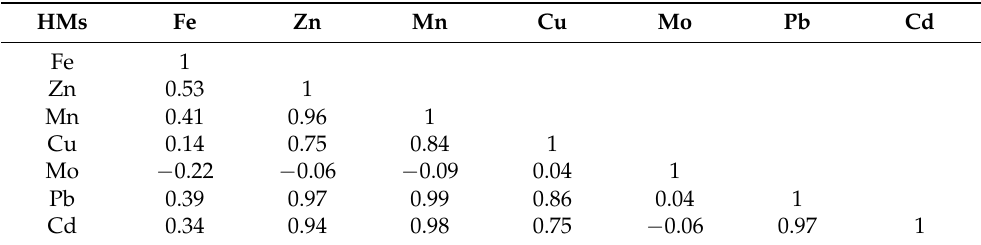
Table 4. Pearson’s coefficients of correlations between HMs.